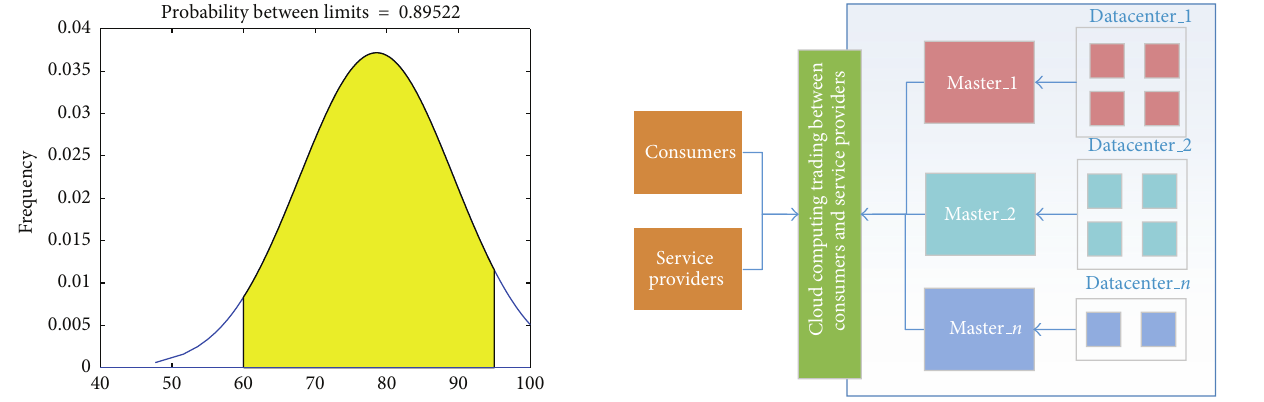
Figure 4: Cloud service market